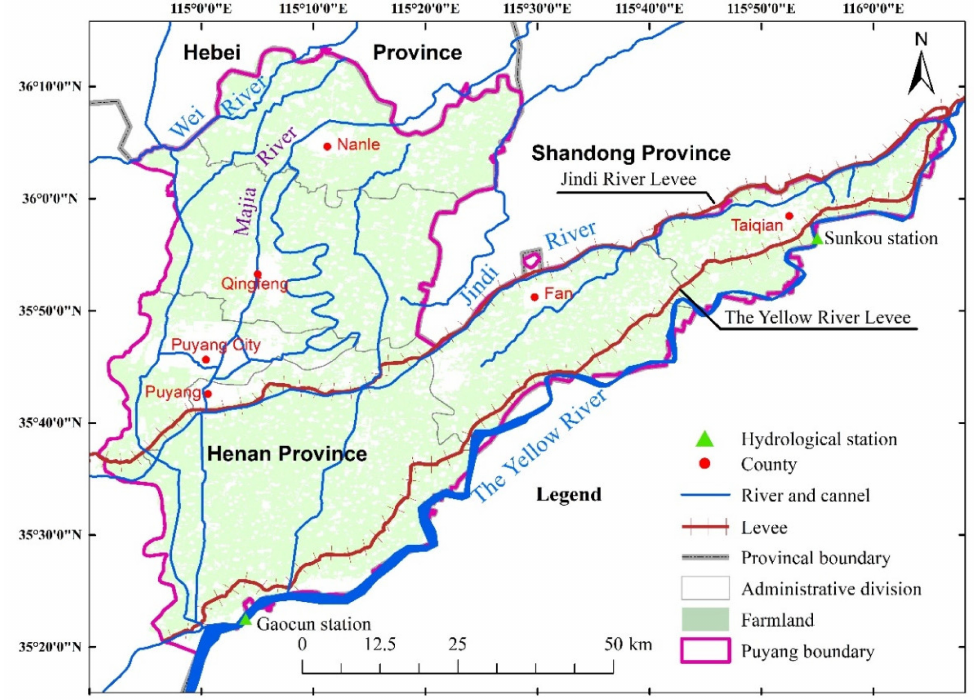
Figure 1. Administrative divisions and water system in Puyang